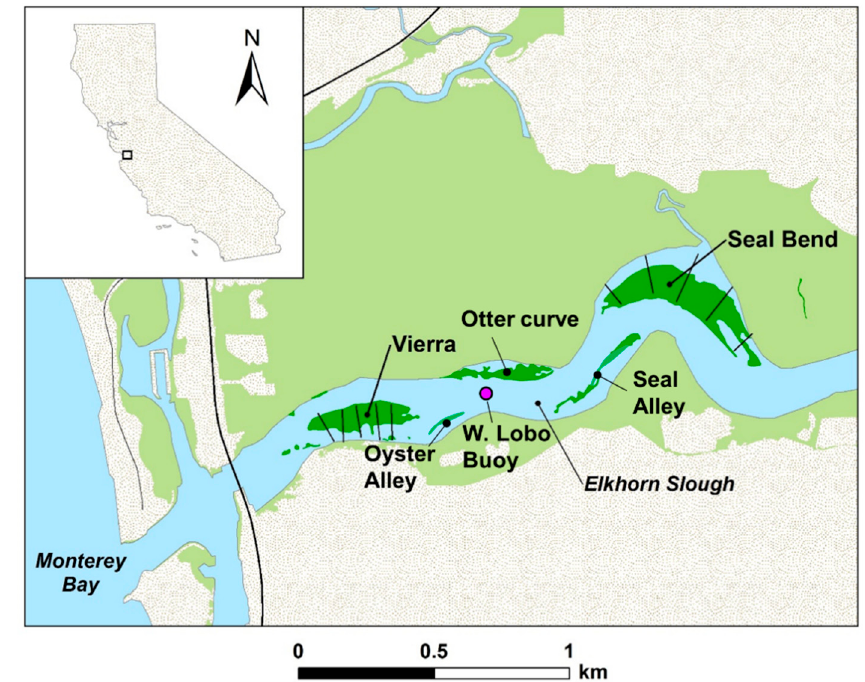
Figure 2. A highlighted portion of Elkhorn Slough with the identification of 5 different eelgrass beds considered in this study. Field data (PR019-PR022) was collected coincident with the PRISM overflight from a boat next to the West LOBO buoy, identified with a magenta circle. The routine monitoring transects for the eelgrass beds at Seal Bend and Vierra are shown as black lines adapted from [40].